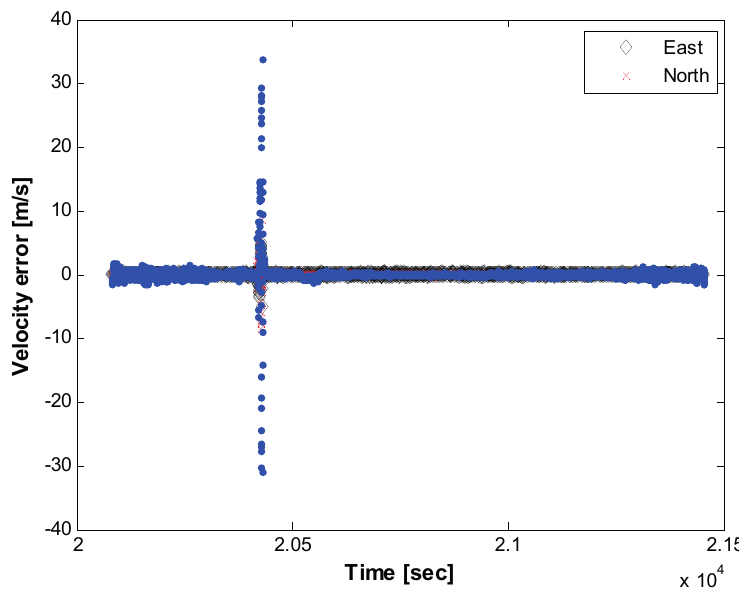
Figure 17. Velocity error while cruising, horizontal components only.